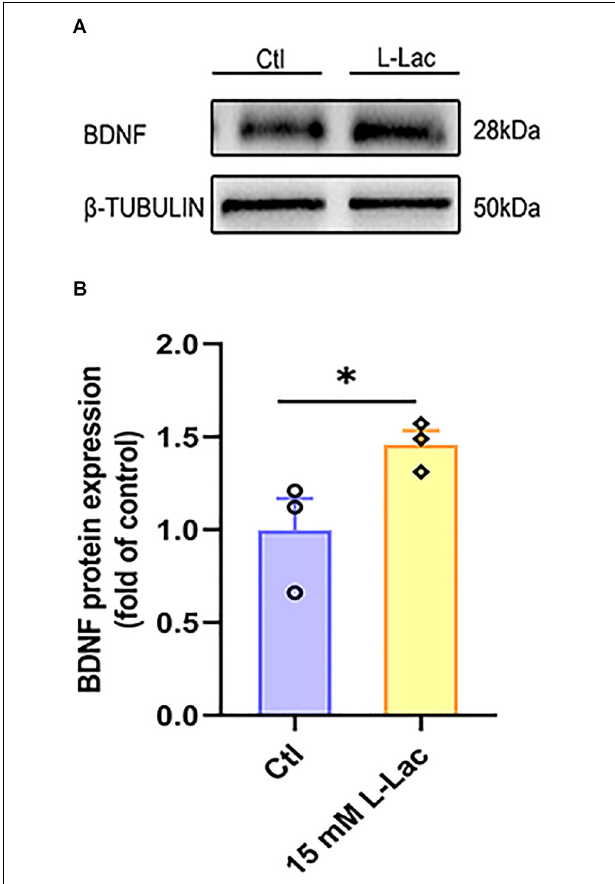
FIGURE 8 | Lactate increased BDNF expression in primary hippocampal cells. The mice primary cultured hippocampal cells were treated with 15 mM L-lactate for 3 h to observe the effect of lactate on BDNF expression. The protein expression of Brain-derived neurotrophic factor (BDNF) was detected by WB. (A) Representative WB image. (B) BDNF protein expression. TUBULIN as the loading control. N = 3 in three independent experiments. ∗ P ≤ 0.05 compared with the Ctl group by non-parametric tests. Values are expressed as mean ± standard error of the